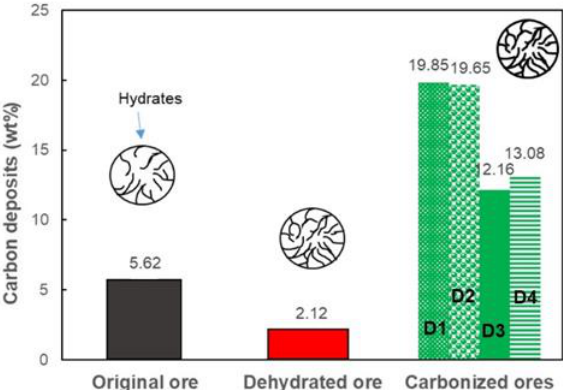
Figure 2. Carbon deposit changes of the samples: original ore (before dehydration), dehydrated ore, and carbonized ores (D1, D2, D3, and D4).